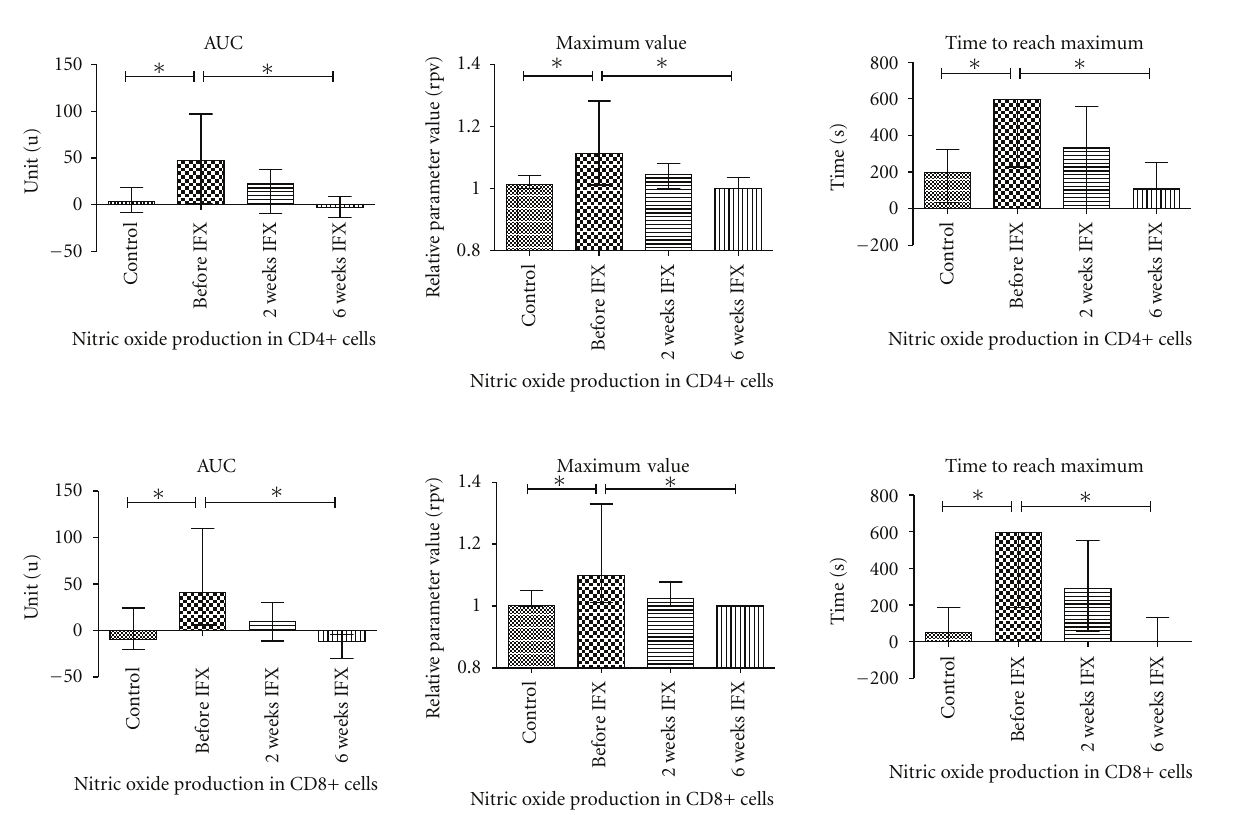
Figure 3: Nitric oxide generation kinetics in CD4+ and CD8+ cells following activation in healthy controls ( n = 9) and ankylosing spondylitis patients before infliximab (IFX) therapy ( n = 13) then 2 and 6 weeks after initiation of IFX ( n = 11 and 8, resp.). ∗ P < 0 . 05 AUC: area under the curve. For details of IFX therapy, see